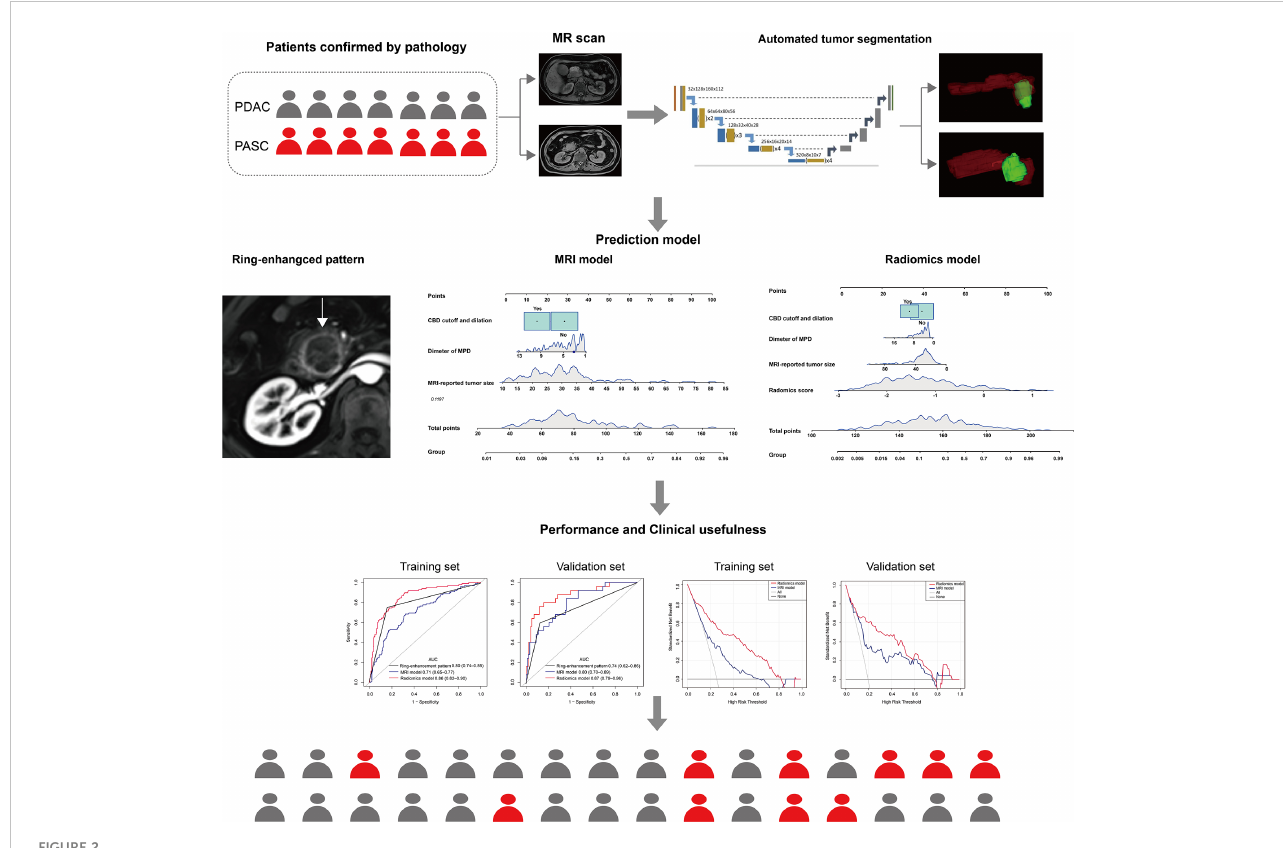
FIGURE 2 The work fl ow of the two